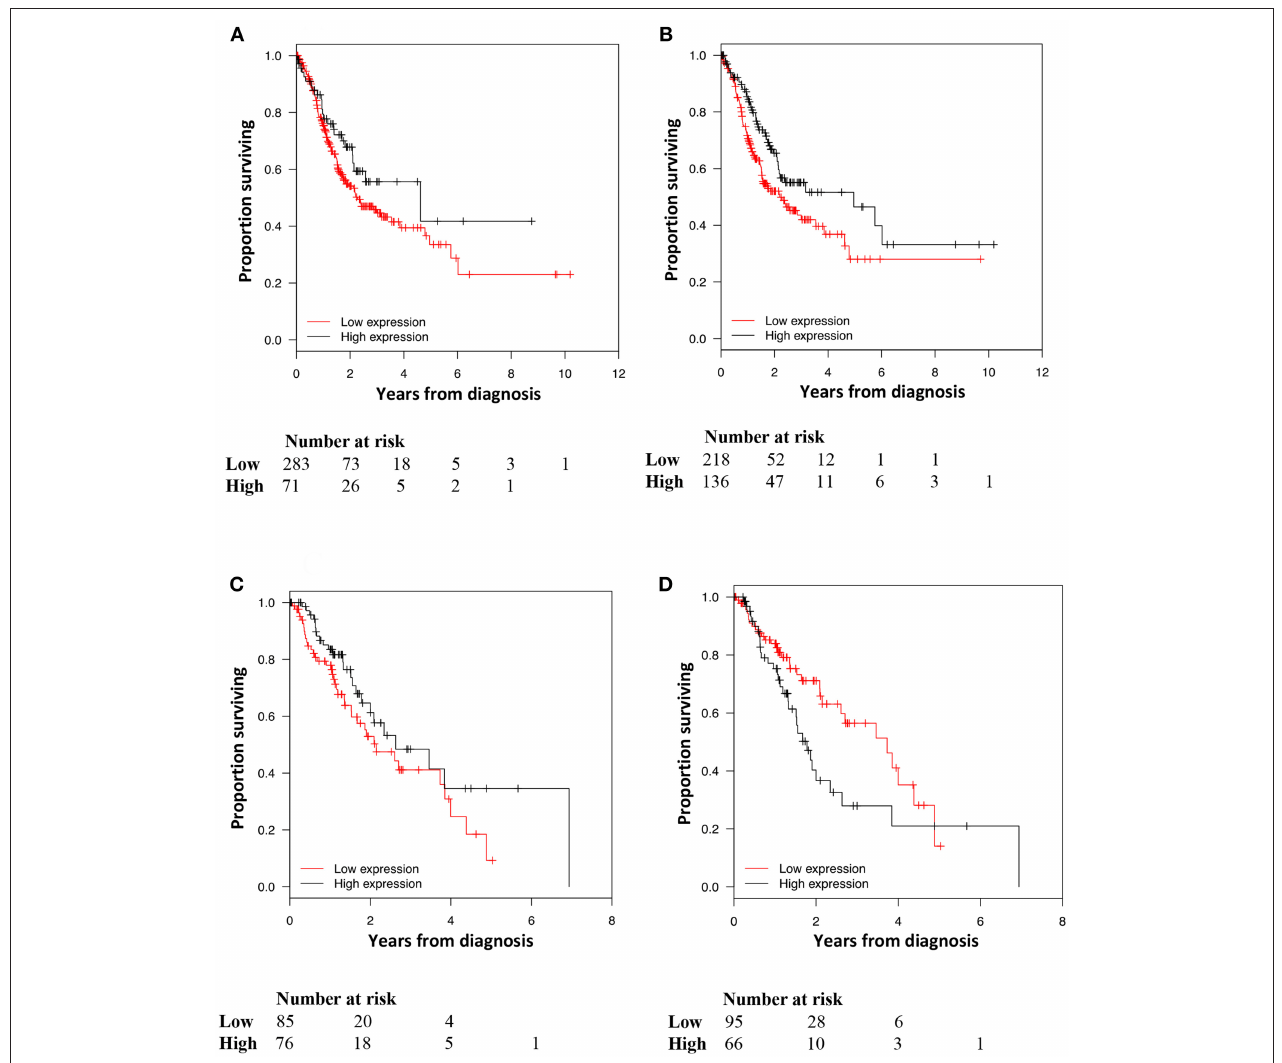
FIGURE 5 | Kaplan-Meier estimates of OS in strata according to high and low (A) PD-L1 and (B) PD-1 mRNA expression in gastric cancer and high and low (C) PD-L1 and (D) PD-1 mRNA expression, in esophageal cancer, in TCGA. (A) p = 0.116, (B) p = 0.041, (C) p = 0.168, (D) p = 0.053.